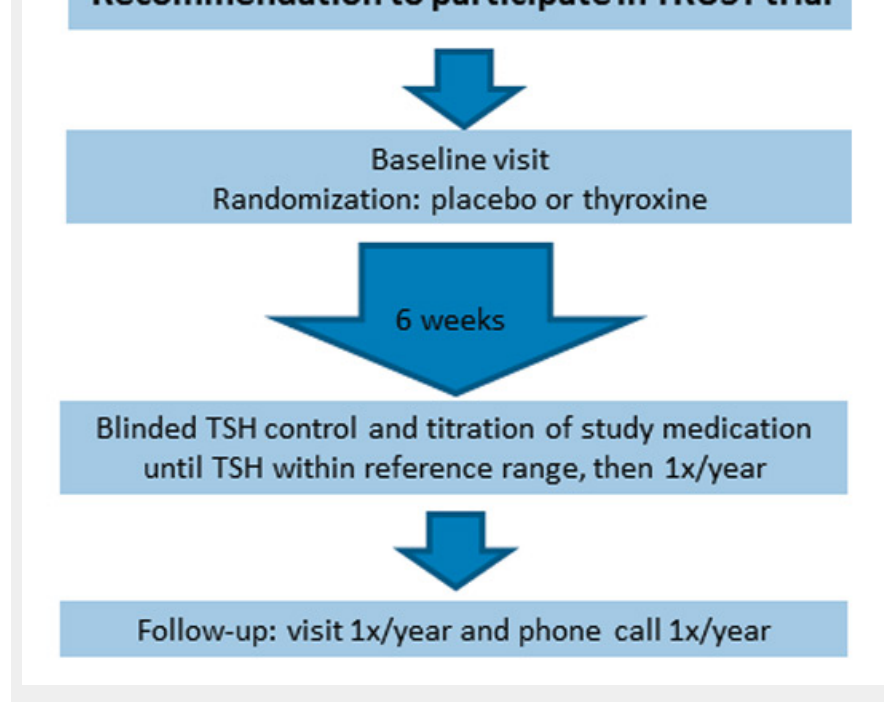
TRUST trial. Process for inclusion in the TRUST trial: Confirmation of subclinical hypothyroidism and patient visits during the course of the trial. See chapter “Conclusion and perspectives: The TRUST trial” for more details. Figure: adapted according to [59]. fT4 = free thyroxine; GP = general practitioner; TSH = thyroid-stimulating